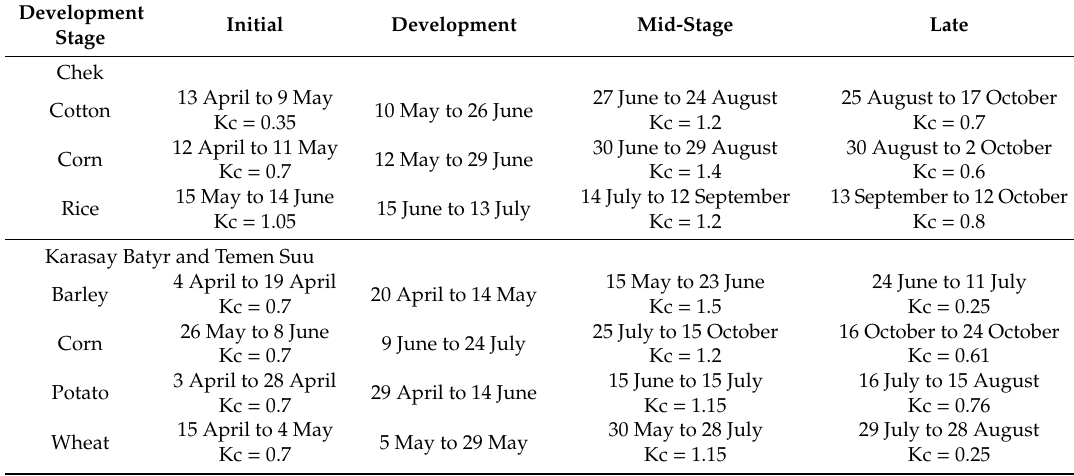
Table 3. Development stages and crop coe ffi cient (Kc) values of the investigated crops after field observations. The Kc during development stage is interpolated linearly from the Kc of the initial stage to the Kc of the mid stage. The late Kc is interpolated linearly from the Kc of the mid stage to the Kc end , which is given in the table. Definitions of the development stages and Kc values were obtained from